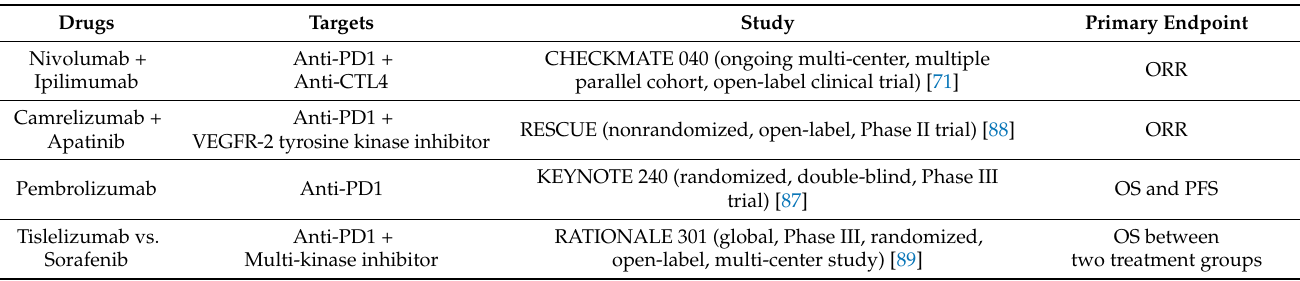
Table 2. FDA-approved drugs and ongoing trials for